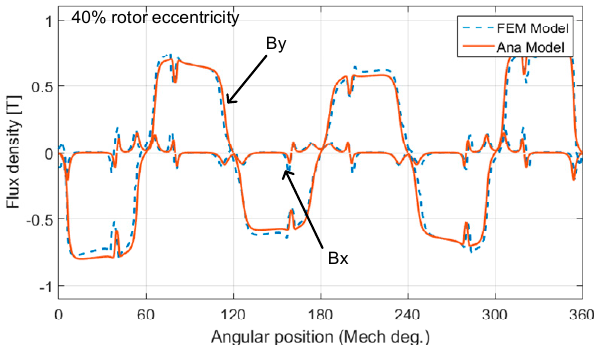
Figure 12. Axial and circumferential components of flux density at the air gap ( l = L − 1 mm) under no-load condition.